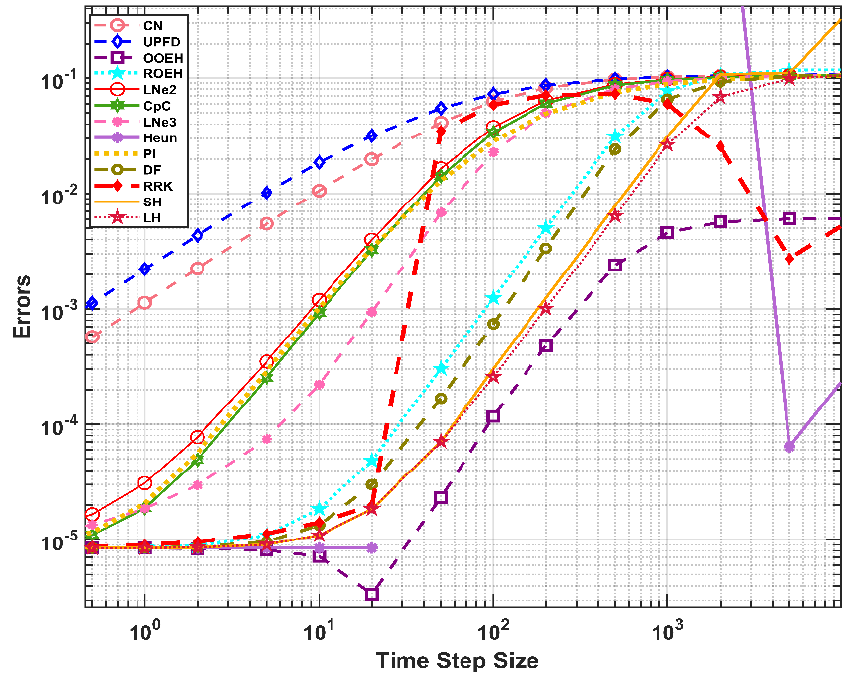
Figure 5. The maximum errors as a function of the time step size ∆ t for the 13 examined methods in the case of an equidistant mesh.